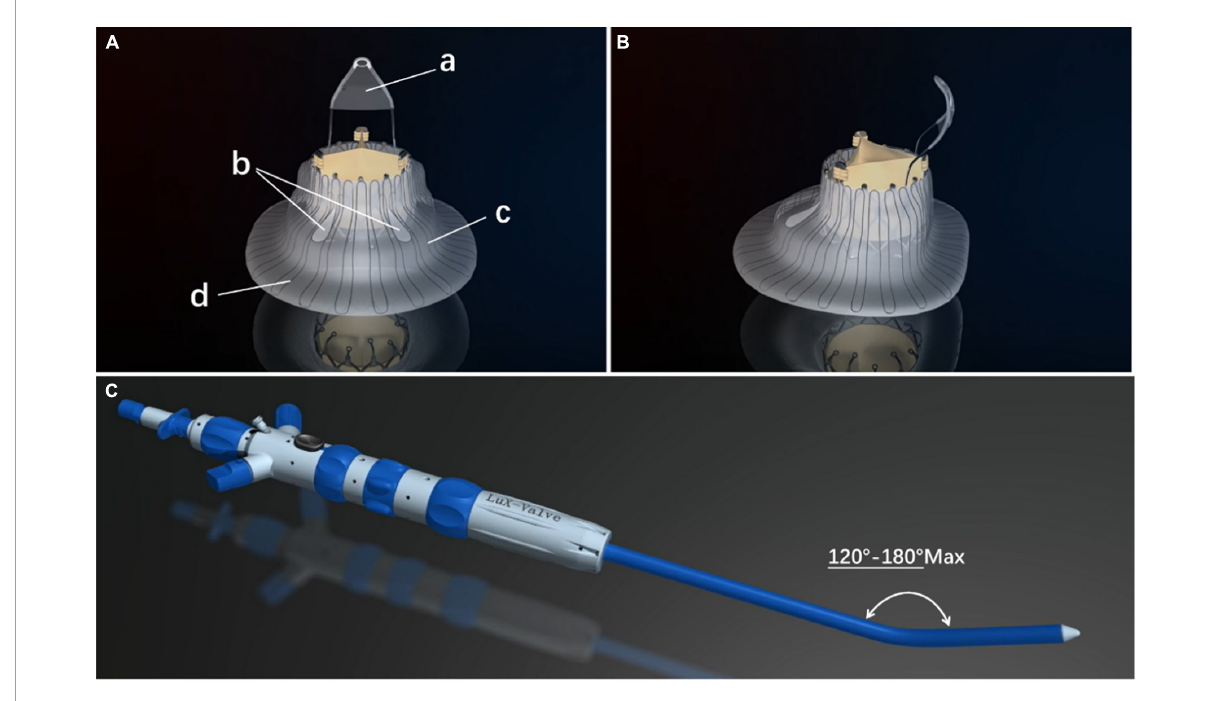
FIGURE2 The LuX-Valve (Ningbo Jenscare Biotechnology, Ningbo, China) is self-expandable. The stent is made of a nickel–titanium alloy and the biological leaflet is bovine pericardium. The bio-prosthesis is implanted via the right atrial approach and fixed in the tricuspid annulus with its own unique anchoring device, independent of the radial support force. The part of the prosthesis located in the right atrium also prevents paravalvular leakage. (A) Right atrial view of the LuX-Valve. The four parts of the LuX-Valve stent include (a) the interventricular anchor, (b) two graspers, (c) the annulus skirt, and (d) the right atrial disc. (B) Lateral view of the LuX-Valve. (C) The delivery system of the